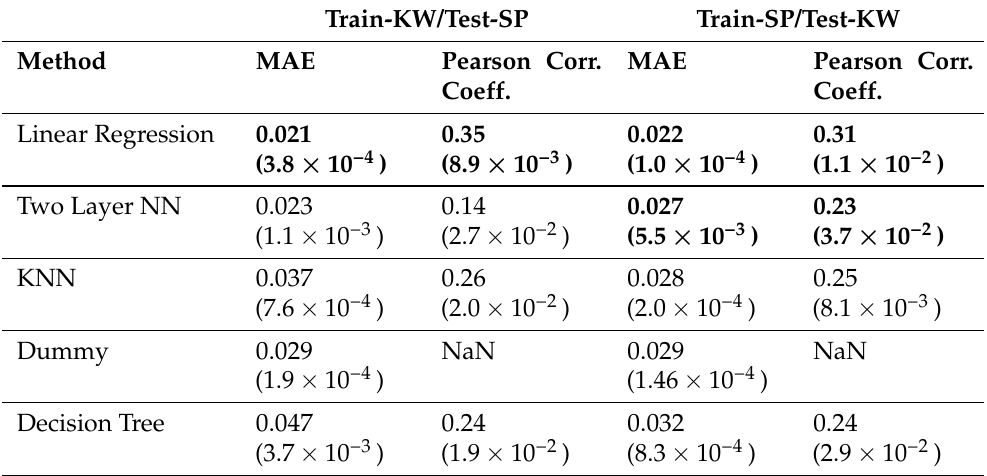
Table 5. Conventional regression results with transfer learning using CIR-derived